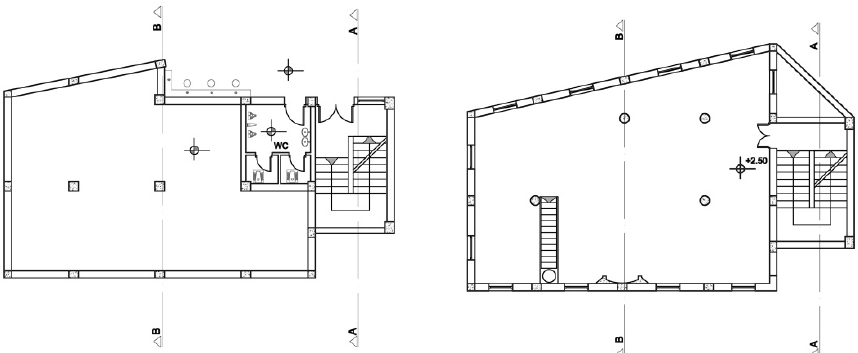
Figure 15. The Imam Azam Mosque’s ground floor plan in the permit and ground floor plan in practice.